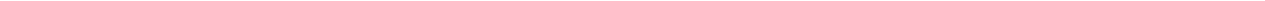
Fig. 6 Proteasome perturbation increases presynaptic Ca 2+ in fl ux, RRP size and the amplitude of the fast recovery phase. a Representative two-photon line scans of a control bouton after loading with OGB-1 and Alexa-568. Arrowhead indicates AP-stimulus onset. b Representative spatially averaged Ca 2+ transients of a control synapse and a DTS pre synapse (average of 10 sweeps). c Quanti fi cation of Ca 2+ -transient peak amplitudes of control and DTS pre synapses and cumulative frequency plot. Proteasome inhibition results in a signi fi cant increase in the peak amplitude compared to control cells. d Baseline fl uorescence of the Ca 2+ indicator OGB-1 and the Ca 2+ -independent dye Alexa-568 in the two genotypes. Baseline OGB-1 fl uorescence is signi fi cantly higher in DTS pre synapses. The decay time constant τ is not changed. Mean ± s.e.m.; n ≥ 53 boutons; * p < 0.05; **** p < 0.00001; Wilcoxon rank-sum test. e Left: Representative EPSC trains in response to 60-Hz stimulation (60 stimuli, 1 mM [Ca 2+ ] e ) for control cells and DTS pre mutant cells. Right: cumulative EPSC charge was calculated by back-extrapolation of a linear fi t (black line) to the last 15 stimuli of the cumulative EPSC integrals to time point zero. f RRP size was calculated by dividing cumulative EPSC charge by the average mEPSC charge. g Left: Example of EPSCs during 60-Hz stimulation (60 stimuli, 2 mM [Ca 2+ ] e ) followed by recovery pulses given at intervals of 25, 75, 175 and 475 ms after the last train stimulus of the indicated genotypes. Right: Average recovery (mean EPSC amplitude at a given interval divided by the fi rst EPSC amplitude of the 60 Hz train) versus recovery interval ( Δ t ) of the indicated genotypes superimposed with biexponential fi ts. Inset shows the data at short intervals. Biexponential fi ts of average data gave the time constants noted in the fi gure. h Average amplitude of the fast recovery component ‘ A fast ’ of the two groups obtained from bi-exponential fi ts of individual synapses. Note the signi fi cant increase in the fast recovery component in DTS pre mutants (there was no difference in A slow and recovery kinetics between the two groups). Mean ± s.e.m.; n ≥ 10 cells; * p < 0.05; ** p < 0.001; Student ’ s t